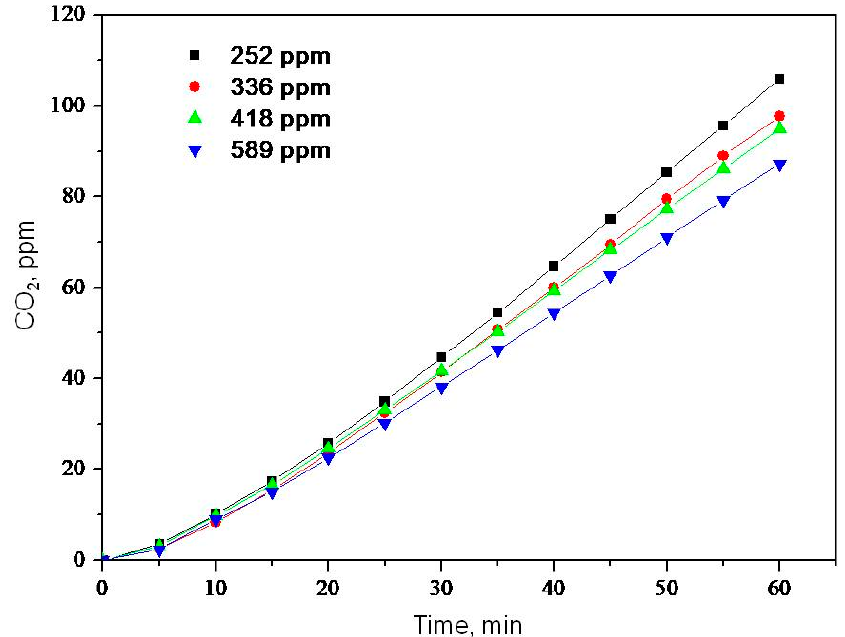
Figure 3. Photocatalytic degradation of hexane (as CO 2 produced) at different initial concentrations of the substrate. TiO 2 (P25, Degussa) commercial powder is used. The experimental error is ≤ 10%.